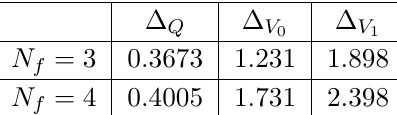
Table 9 . The R -charges determined by the F -maximization for U(2) theories with W = Tr X 3 . h (1 − x 2 )PL I N c =21 = 2 2 x 1 6 + x 1 3 + 2 t u